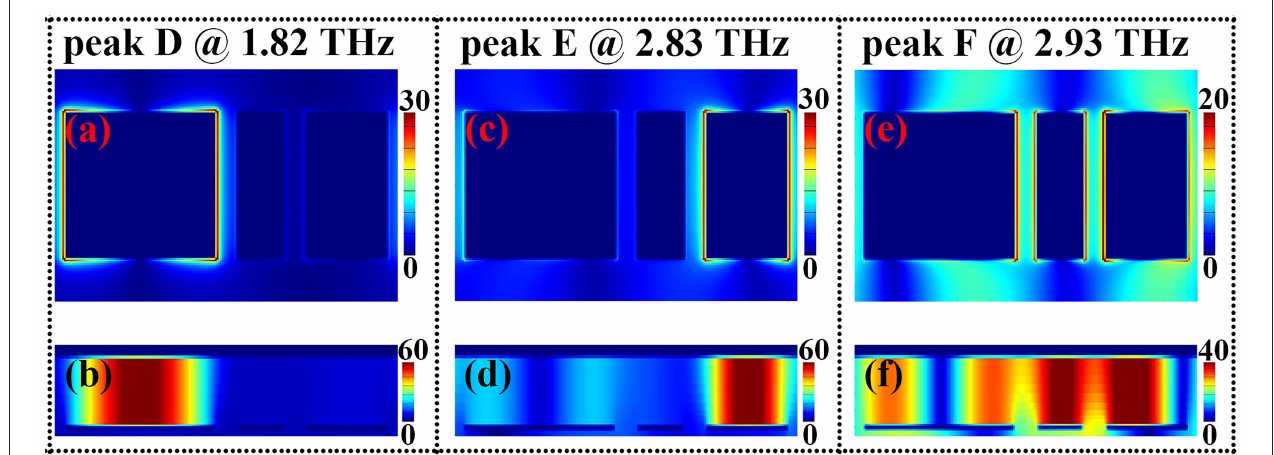
FIGURE 7 | Panels (A,B) are respectively the electric and magnetic field patterns of the absorption peak D at 1.82 THz; (C,D) are respectively the electric and magnetic field patterns of the absorption peak E at 2.83 THz; (E,F) are respectively the electric and magnetic field patterns of the absorption peak F at 2.93 THz.